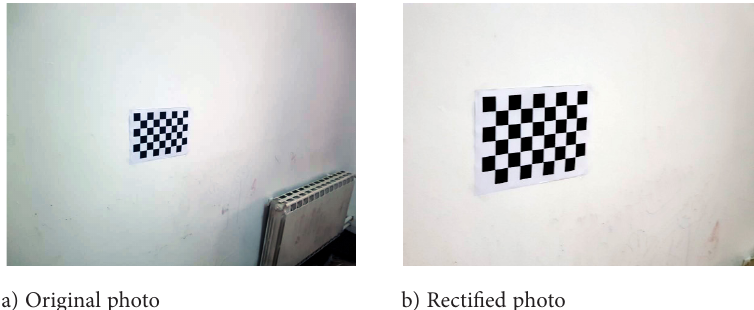
Figure 2. Sample of a pair of photos for chessboard